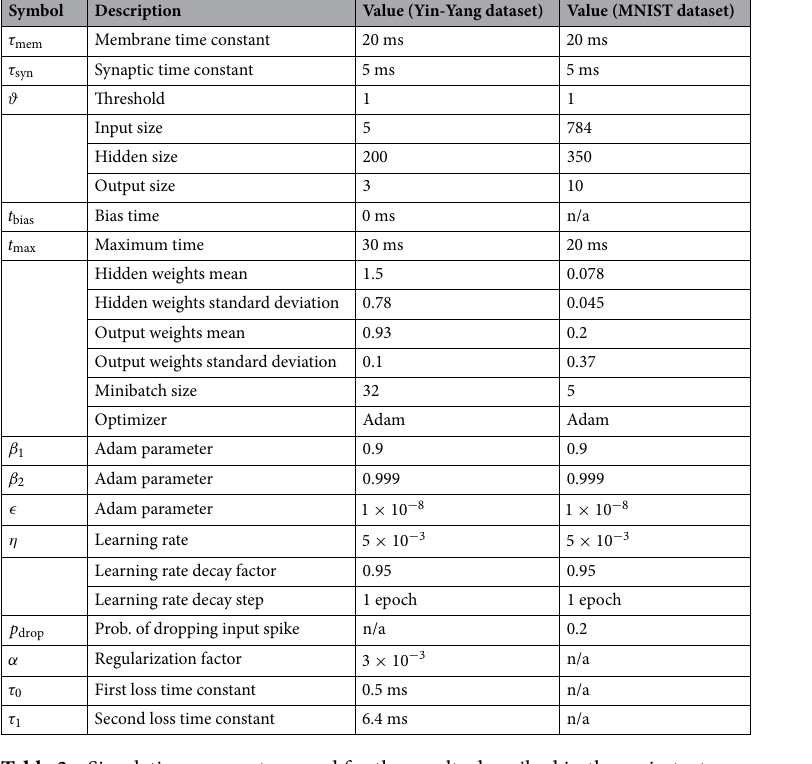
Table 3. Simulation parameters used for the results described in the main